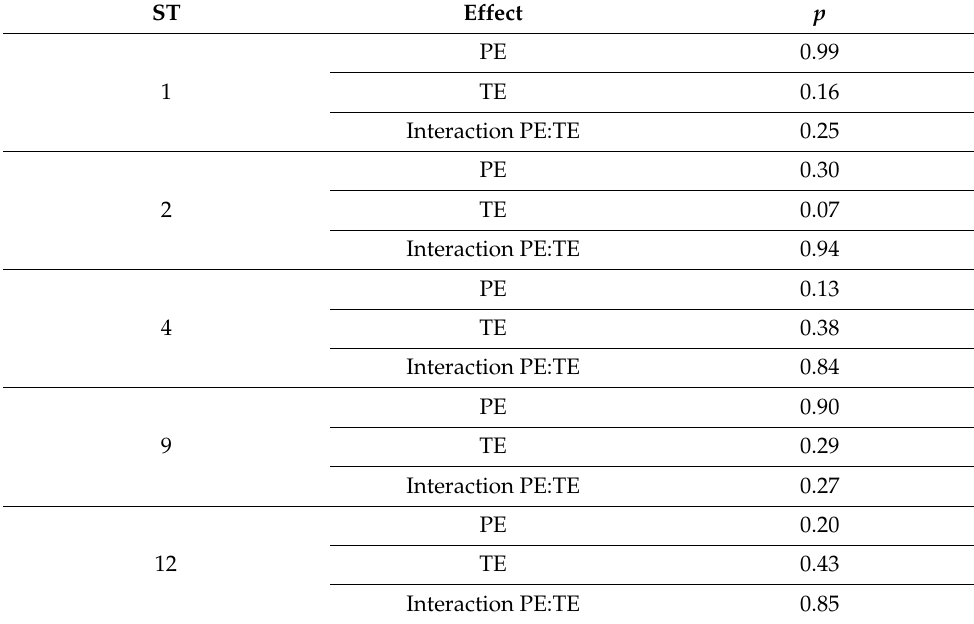
Table 5. Fixed storage time—two-way ANOVA